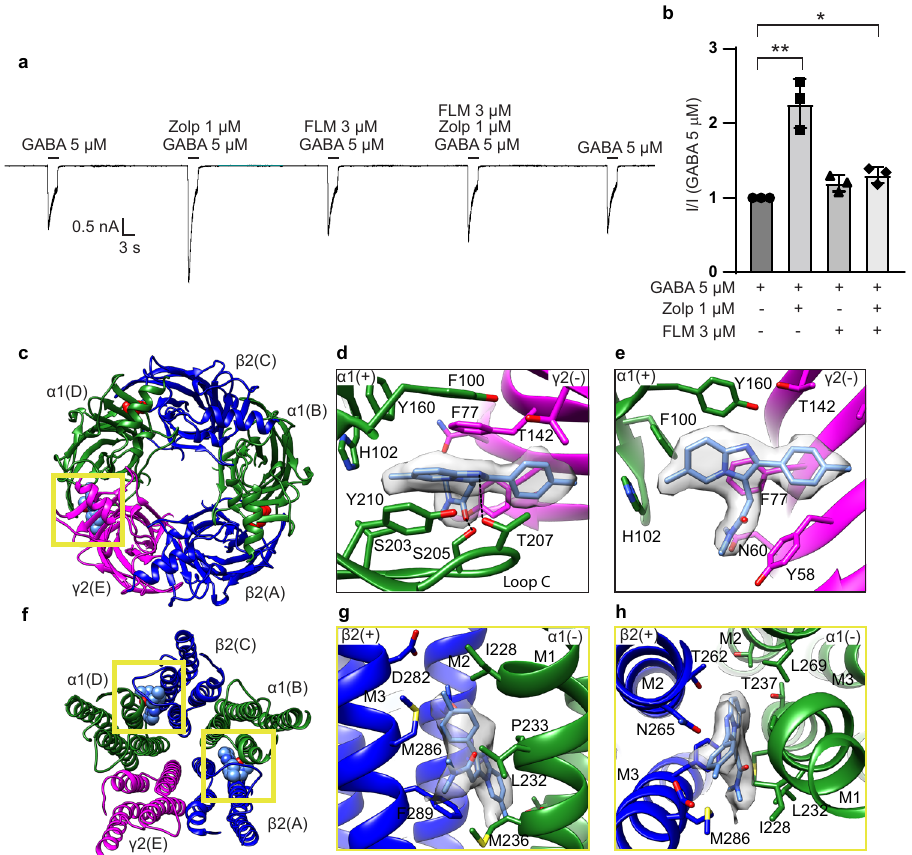
Fig. 2 | Zolpidem activity and binding sites. a Representative patch-clamp electrophysiology of the cryo-EM construct recorded from three independent cells, showing zolpidem potentiates the GABA response and fl umazenil blocks this potentiation. b Statistical analysis of recordings as in a from three inde- pendent cells. Bar graph shows mean responses with standard deviation for the fractional zolpidem potentiation with and without fl umazenil. Two-sided Welch ’ s t -test was used. A p -value of ≤ 0.05 was considered statistically sig- ni fi cant. * p =0.042; ** p =0.022. c Atomic model of ECD viewed from synaptic side; yellow box indicates benzodiazepine binding site bound with zolpidem